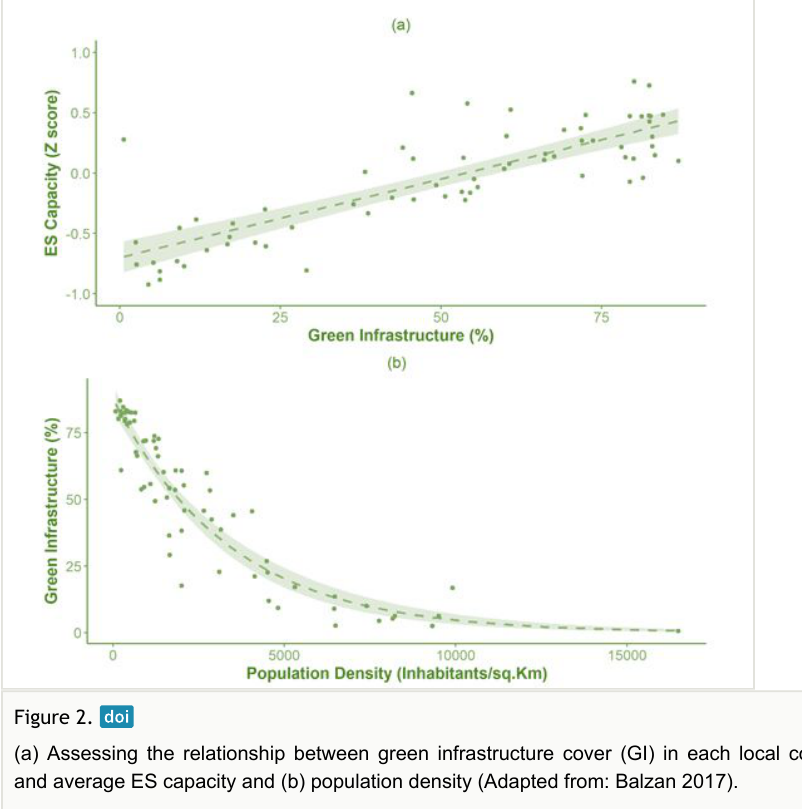
(a) Assessing the relationship between green infrastructure cover (GI) in each local council and average ES capacity and (b) population density (Adapted from: Balzan